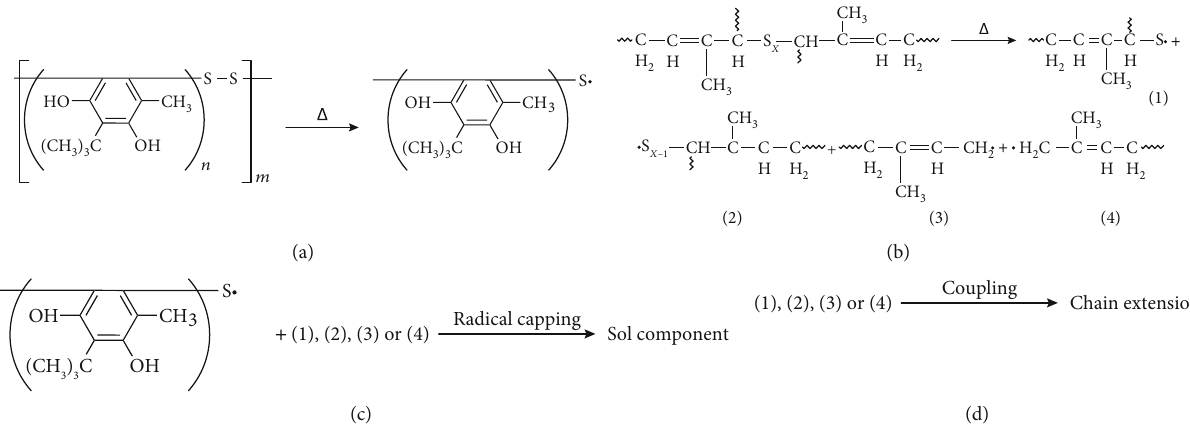
Figure 1: Schematics of the possible chemical reactions during the waste tire reclamation involving activator 450. Under the heating and mechanical shearing, the disul fi de bonds in the activator can break, resulting in sulfenyl radicals (a), and the S-S crosslinks and C-C bonds in the rubber can cleave, resulting in molecular segments with radicals (b). The radical species on the molecular fragments can get neutralized by coupling with each other or with the sulfenyl radicals produced. Table 1: The recipe for curing reclaimed rubbers. Ingredients